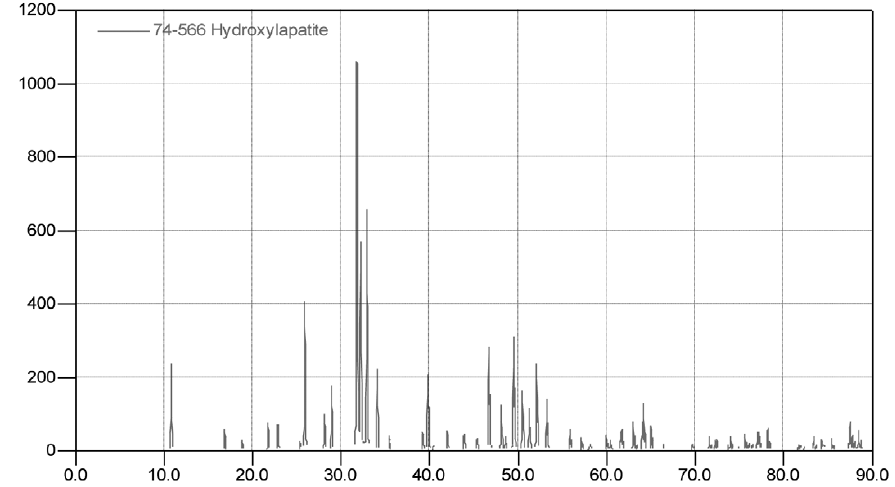
Figure 4 - Card 74-566 corresponding to the xRD of